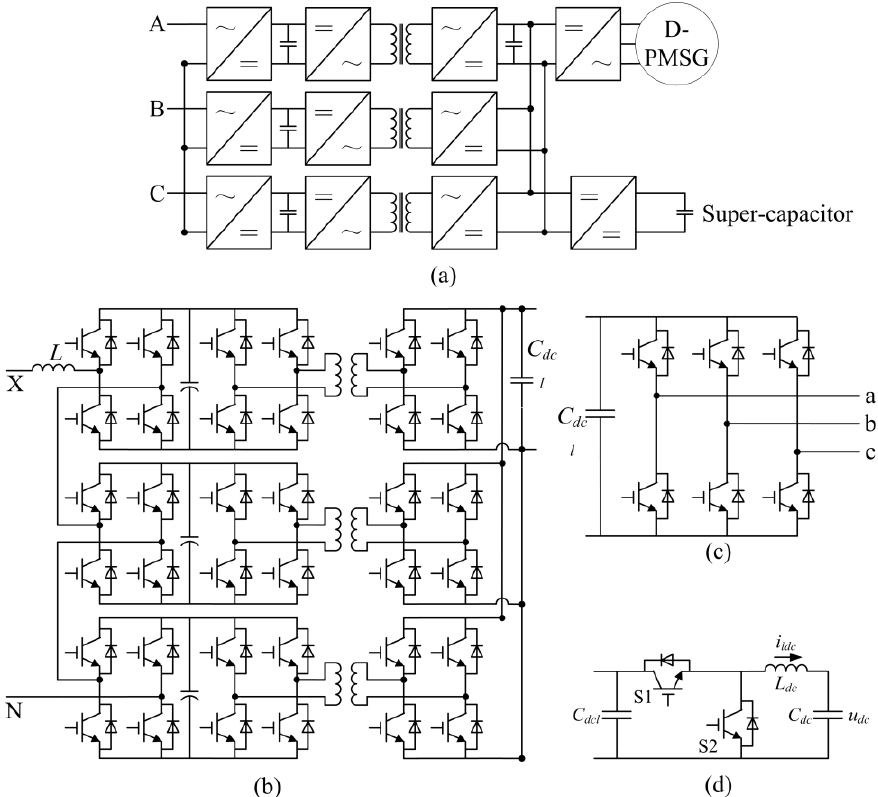
Figure 1. Topology of the system. ( a ) Basic diagram of the system; ( b ) Single phase topology of the high voltage side and isolation stage converters; ( c ) Topology of the generator side 3 phase converter; and ( d ) Topology of the DC/DC